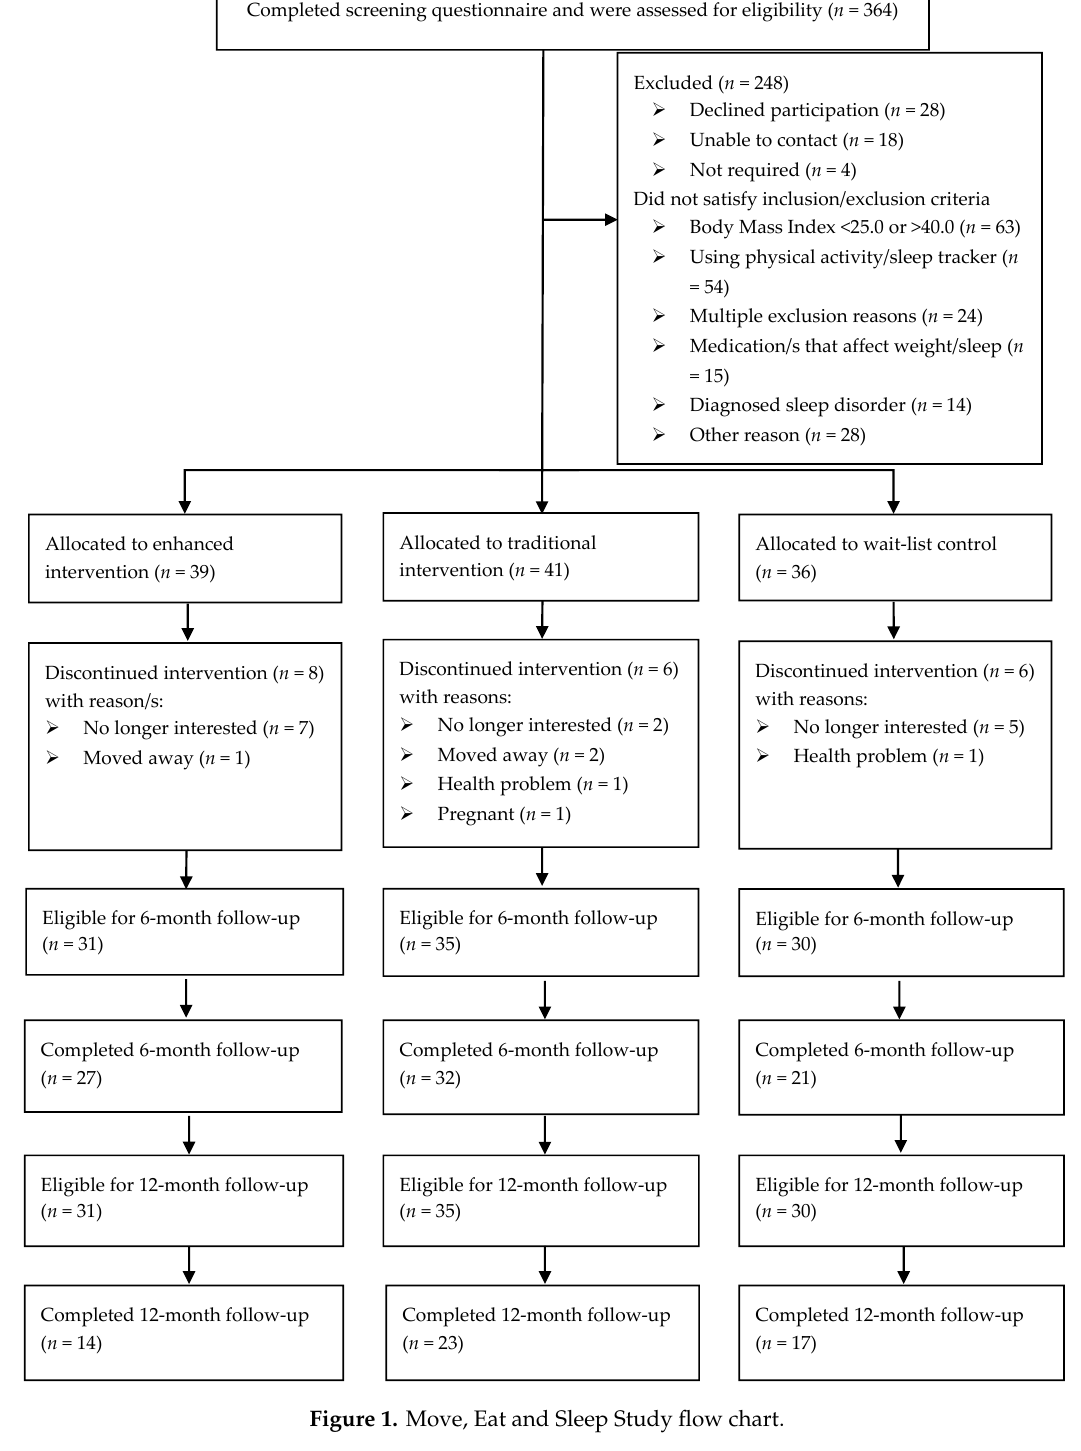
Figure 1. Move, Eat and Sleep Study flow chart.